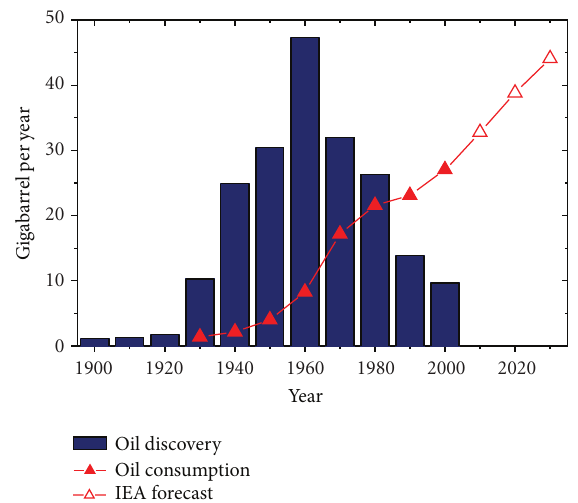
Figure 2: Discovery of conventional oil reserves (blue) and oil con- sumption (red)